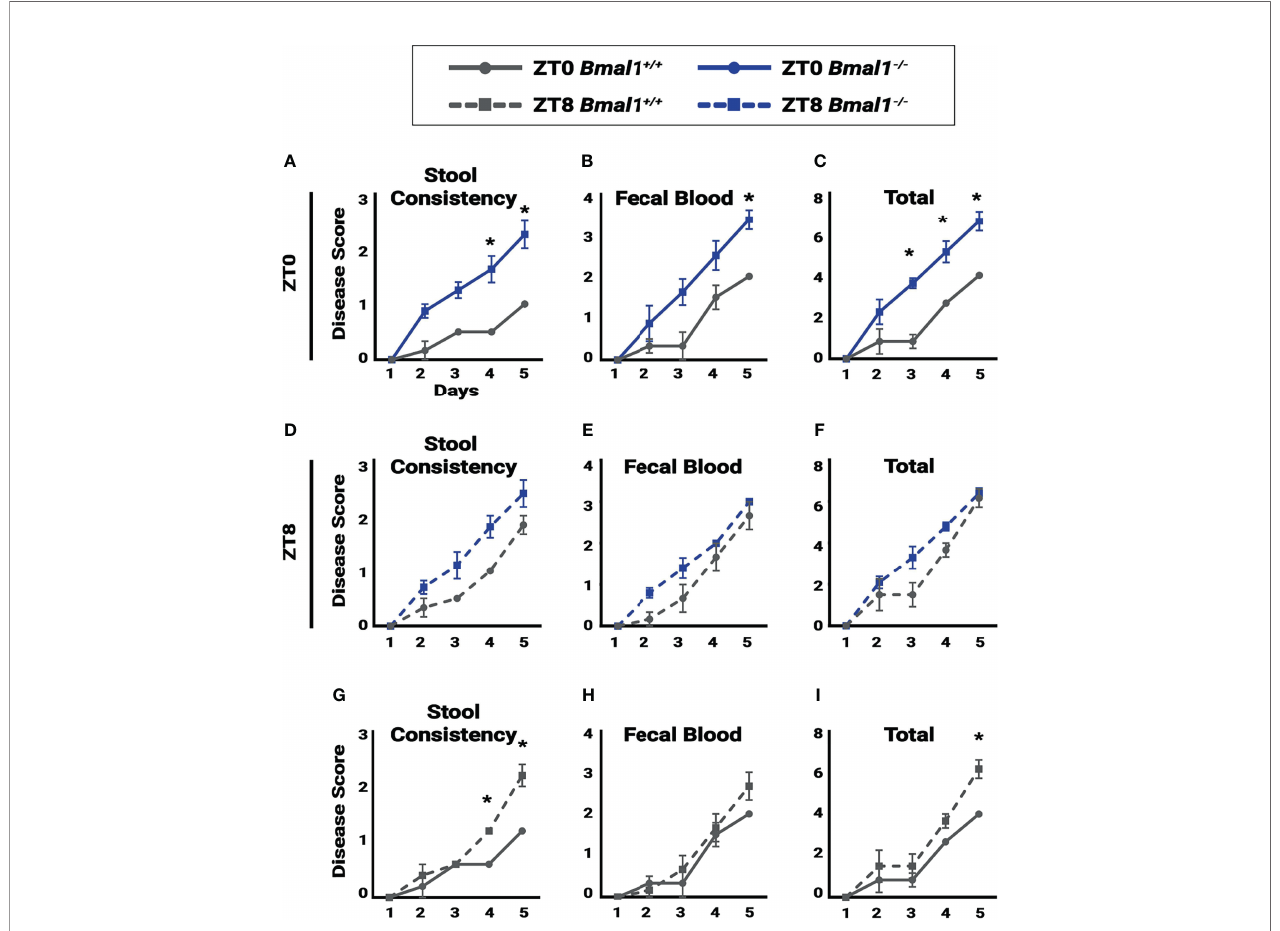
FIGURE 5 | Colitis is time dependent. Disease score was assessed for individual mice to test for the severity of symptoms associated with colitis during a 5 day, 5% DSS treatment. A lower disease score is exhibited in Bmal1 +/+ control mice at ZT0 due to: (A) decreased stool consistency (Two-way ANOVA, *p=0.0042, F (4,25) =5.004; Tukey ’ s test, Day 4 *p=0.0009, Day 5 *p=0.0002) and (B) decreased fecal blood on the fi nal day of treatment and (Two-way ANOVA, p=0.1199, F (4,25) =2.036; Tukey ’ s test, Day 5 *p=0.0496). (C) Overall total disease score (Two-way ANOVA, *p=0.0093, F (4,25) =4.241; Tukey ’ s test, Day 3 *p= 0.0016, Day 4 *p=0.0067, Day 5 *p=0.0033). No difference between Bmal1 +/+ control and Bmal1 -/- mutant mice was seen in (D) stool consistency, (E) fecal blood, and (F) overall total disease score at ZT8 upon induction of DSS-colitis (Two-way ANOVA, ns; Tukey ’ s test, ns). Time dependence in disease severity is apparent in circadian-competent mice when comparing Bmal1 +/+ controls at ZT0 and ZT8. (G) Increased disease activity in stool consistency at ZT8 (Two-way ANOVA, *p=0.0006, F (4,20) =7.883; Tukey ’ s test, Day 4 *p=0.0252, Day 5 *p<0.0001). (H) Although no time dependence is seen in fecal blood (Two-way ANOVA, p=0.4930, F (4,20) =0.8810; Tukey ’ s test, ns), (I) Increased total disease activity upon induction of DSS at ZT8 is observed (Two-way ANOVA, p=0.1610, F (4,20) =1.839; Tukey ’ s test, Day5 *p=0.0367). (All error bars